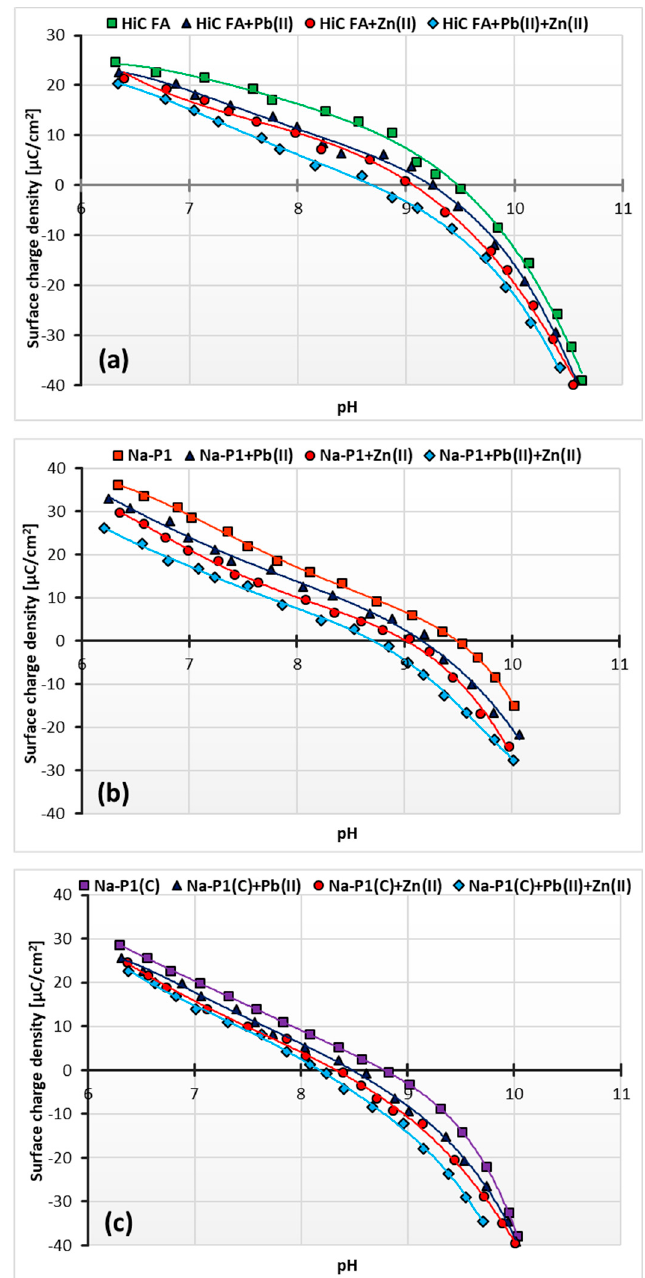
Figure 11. Surface charge density of HiC FA ( a ), Na-P1 ( b ) and Na-P1(C) ( c ) without and with one or two heavy metal ions.